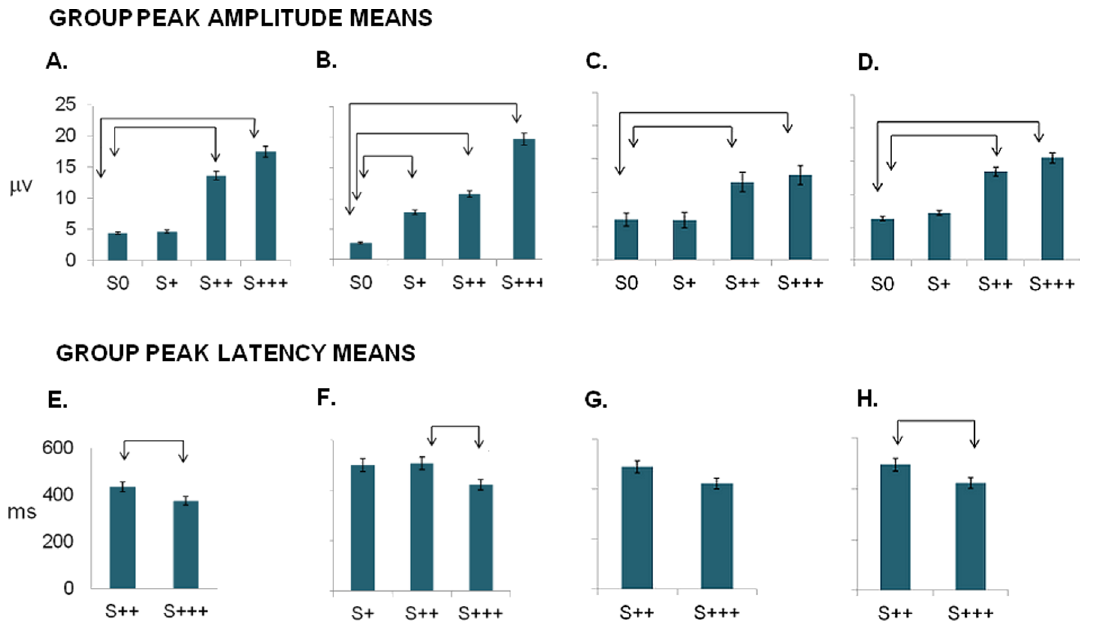
Figure 5. Summary plots of P300 peak amplitude and latency means for averaged ERPs: larger and faster responses for most salient stimuli. Top: A, B, C, E - mean peak amplitudes for A. Color/Luminance (exp I); B. Phase offset (exp II); C. Chrominance (Exp III); D. Luminance (exp IV) evoked average ERPs. Bottom: E, F, G, H - mean peak latencies for E. Color/Luminance (exp I); F Phase Offset (exp II); G. Chrominance (exp III); H. Luminance (exp IV) evoked average ERPs. Amplitudes where highest for the most salient targets, monotonically decreasing along with the physical deviation level (see text for correlation analysis). Significant peak amplitude differences were found between S ++ and S +++ saliency levels from Standard S0. No amplitude differences were found between S + level and Standard S0 average ERPs, except for the Phase Offset experiment (matching behavioral data where only in the later condition a behavioral difference was found, e.g. S + was supraliminal only in this case). Arrow intervals depict significant difference at 0.05. Bars depict confidence intervals for the means at 95%.